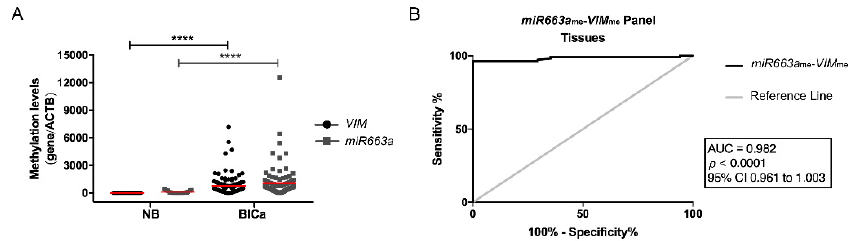
Figure 1. ( A ) Distribution of VIM me and miR663a me levels in normal bladder mucosae (NB; n = 19) and bladder carcinoma (BlCa; n = 94) tissue samples. Mann-Whitney U test, **** p < 0.0001. Median is represented by the red line. ( B ) Receiver operator characteristic (ROC) curve evaluating the performance of the VIM me - miR663a me panel for the identification of BlCa in tissue samples. (AUC—Area under the curve; CI—Confidence interval; ACTB—Beta-Actin; VIM - Vimentin).